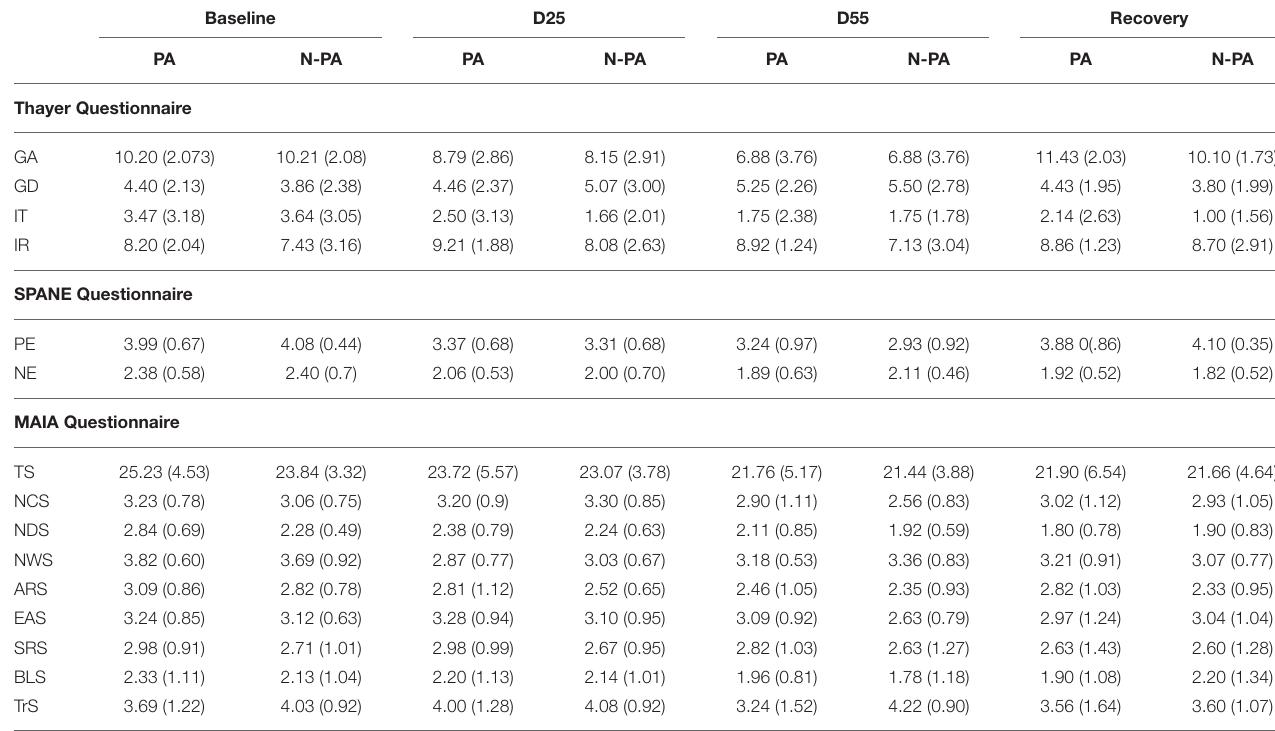
TABLE 3 | Psychological variables description (Mean; Standard Deviation). Baseline D25 D55